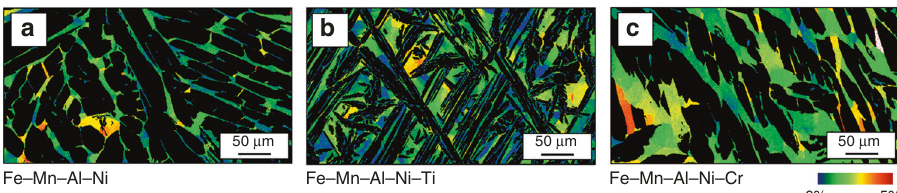
Fig. 4 Grain reference orientation deviation maps for the α phase in Fe – Mn – Al – Ni – X (X = Ti, Cr). ( a ) Fe – Mn – Al – Ni, ( b ) Fe – Mn – Al – Ni – Ti, and ( c ) Fe – Mn – Al – Ni – Cr. The misorientation angles with respect to the average orientation of the grain are highlighted by the color code given. Details on the heat treatment procedure are shown in Supplementary Fig. 1b (lower temperature: 900